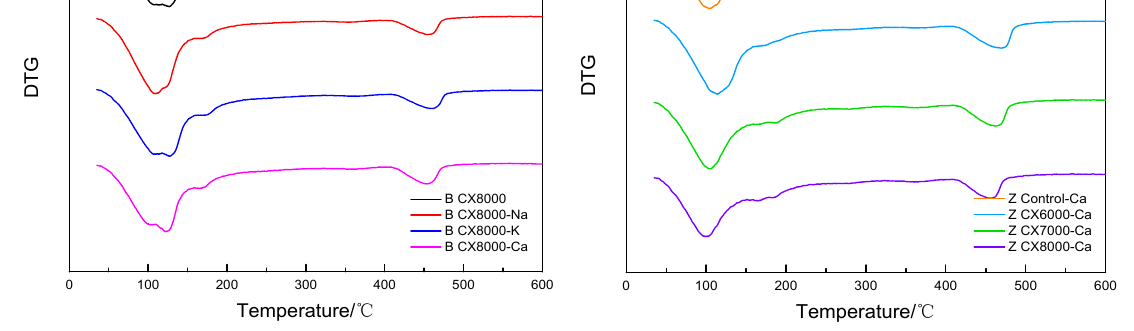
( d ) 28 d DTG curves of ultrafine cement with different curing temperatures.